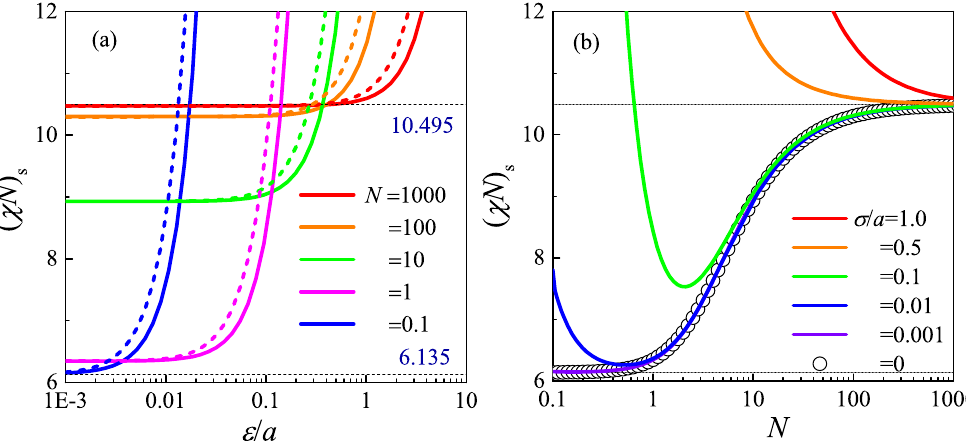
Figure 4. Effects of the interaction range on the spinodal curve of a worm-like diblock copolymer as functions of the interaction range (cid:101) / a and N [73]. In ( a ), intermediate cases for various N are shown, between the flexible (large- N ) and rod-like (small- N ) limits. Solid and long-dashed curves represent the numerical results of the Gaussian and Yukawa interaction functions, respectively. In ( b ), various cases for interaction ranges as indicated are